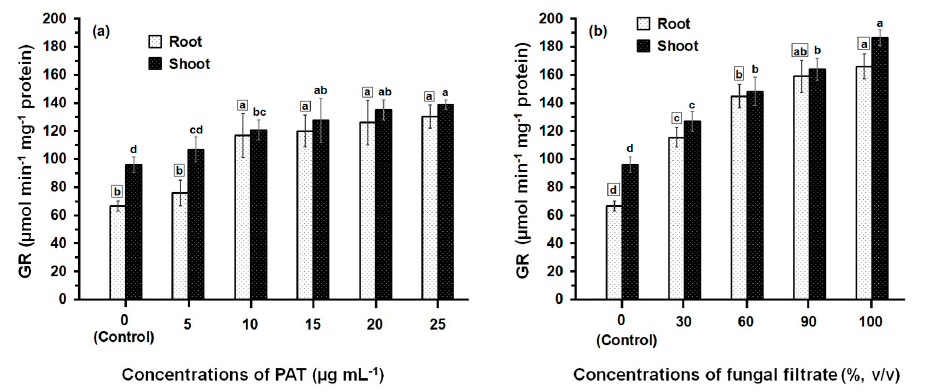
Figure 3. GR activity in root and shoot of 8-day-old maize seedlings treated with different concentrations of PAT ( a ) and fungal filtrate ( b ). Shown are the mean values ± SD of triplicate parallel determinations. All experiments in this figure were performed three times, with similar results. Different letters either for roots (in small squares) or shoots (without squares) at different concentrations are statistically different (LSD test, p ≤ 0.05).